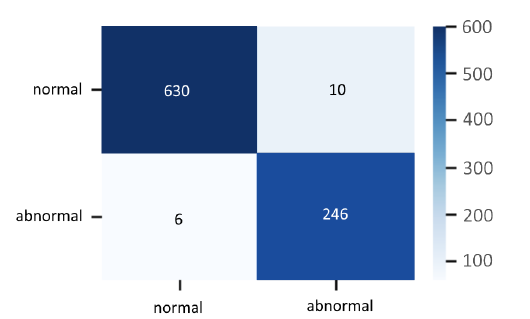
Figure 24. Confusion matrix of the hybrid classifier on the test data.